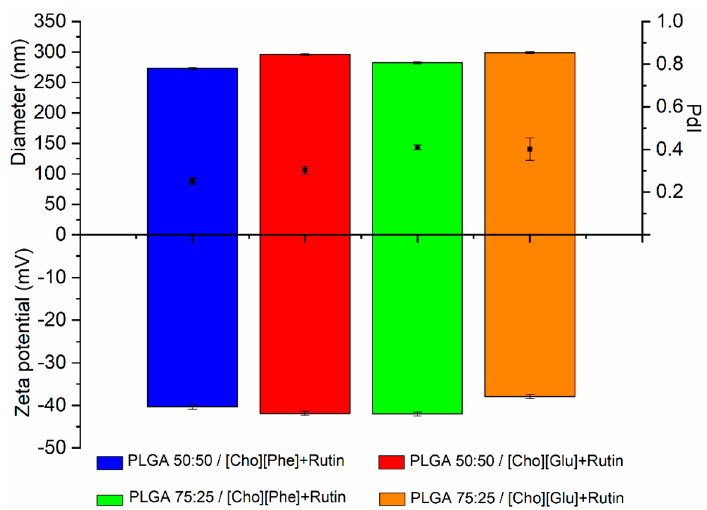
Figure 2. Diameter (nm) (top bars), PdI (black squares), and zeta potential (mV) (bottom bars) of rutin-loaded IL-polymer nanoparticle hybrid systems ( n = 3, mean ± SD).